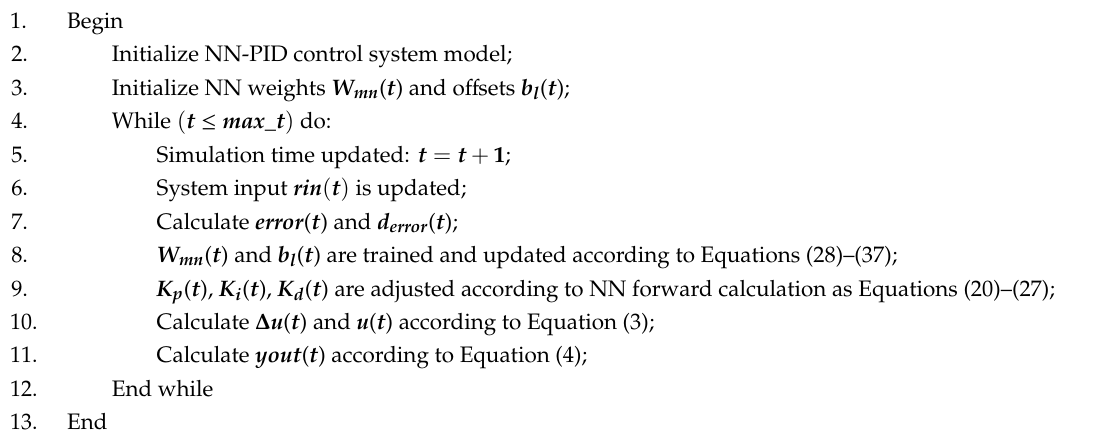
Algorithm 4 NN-PID(neural network based proportion integration di ff erentiation) control